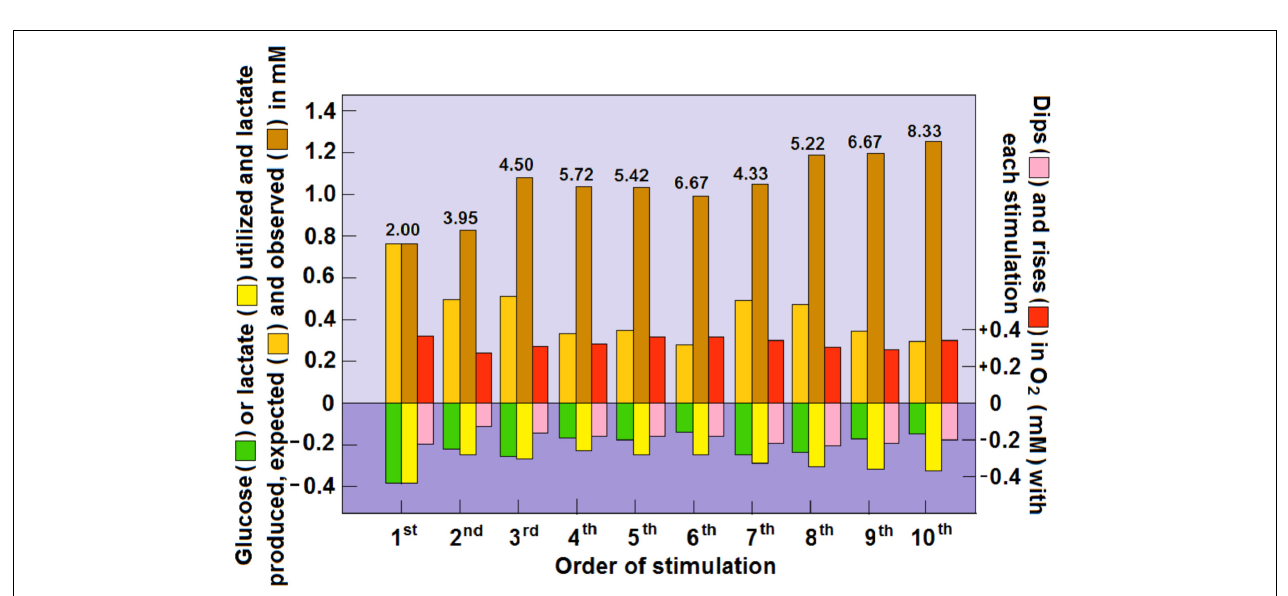
FIGURE 4 | Dynamic relationships of local extracellular glucose, lactate and O 2 levels in the rat hippocampal dentate gyrus during a series of 5 s electrical stimulations of the perforant pathway at 2 min rest intervals. The concentrations of glucose, lactate and O 2 were calculated from their dips and rises as measured by Hu and Wilson (1997) using rapid response sensors in their original study. The numerical values above the columns representing the rises in glucose and lactate post-stimulation are the calculated ratios between the two. For additional details see Figure 3 and Schurr and Gozal (2011).